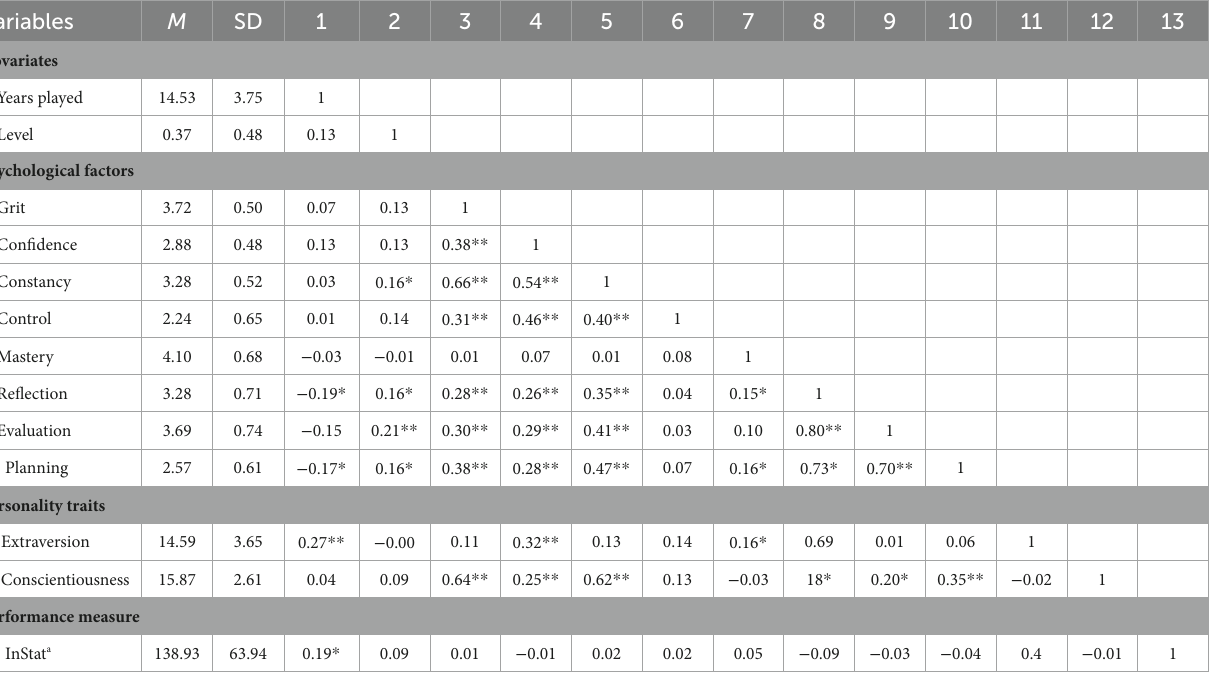
TABLE 2 Bivariate correlations between variables in the study.